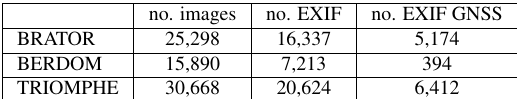
Table 1. Number of images in each